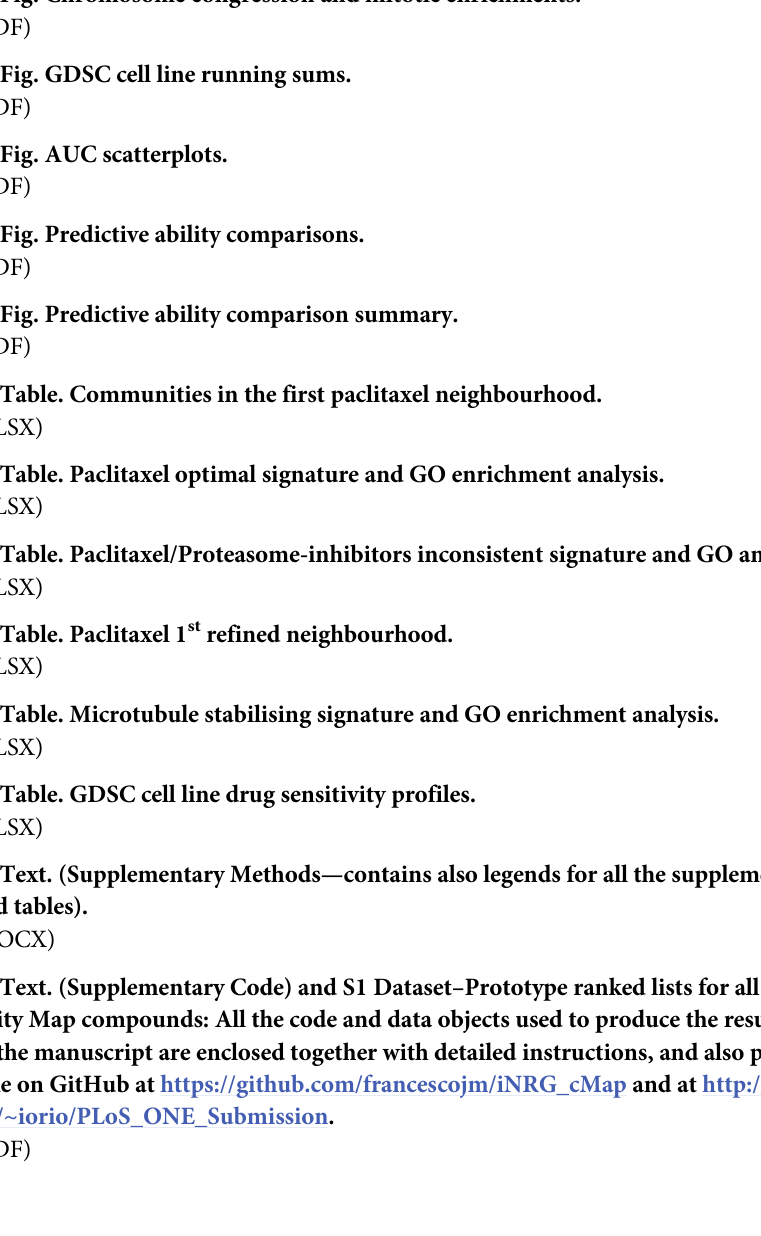
S7 Fig. Predictive ability comparison summary. S1 Table. Communities in the first paclitaxel neighbourhood. S2 Table. Paclitaxel optimal signature and GO enrichment analysis. S3 Table. Paclitaxel/Proteasome-inhibitors inconsistent signature and GO analysis. S4 Table. Paclitaxel 1 st refined neighbourhood. S5 Table. Microtubule stabilising signature and GO enrichment analysis. S6 Table. GDSC cell line drug sensitivity